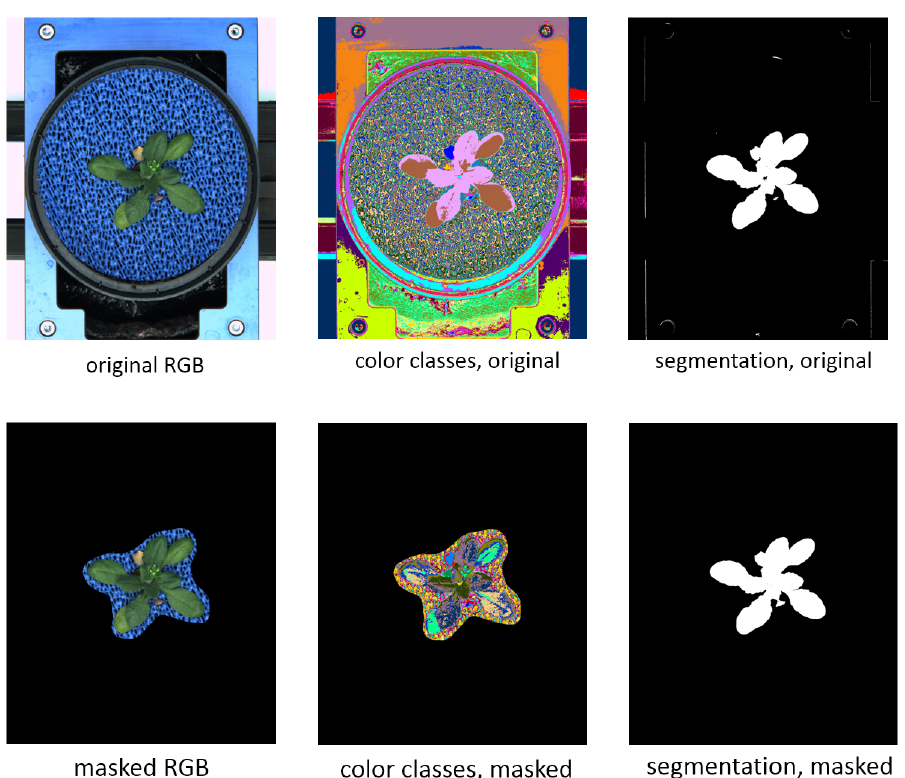
Figure 8. Example of k-means clustering of original full-size and masked images of greenhouse- grown arabidopsis plant. From let to right: original and masked RGB images, k-means color classes (k = 25), results of plant